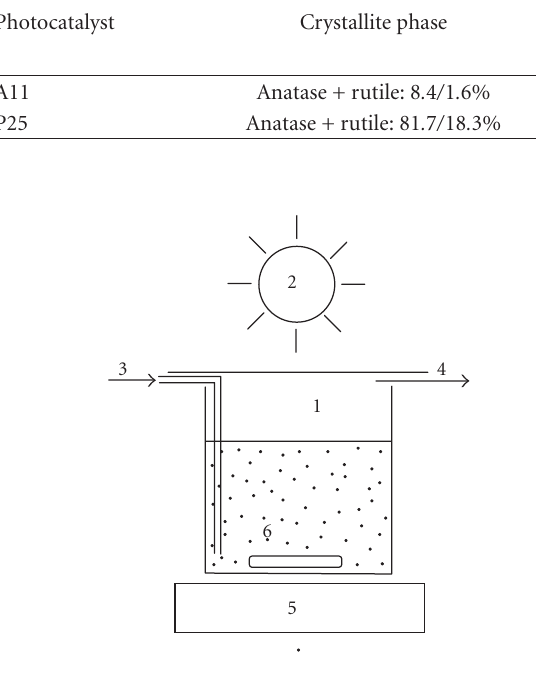
Figure 1: The scheme of apparatus for the photocatalytic reactions. (1) Batch photoreactor, (2) light source, (3,4) gas inlet and outlet, (5) magnetic stirrer, (6) reaction